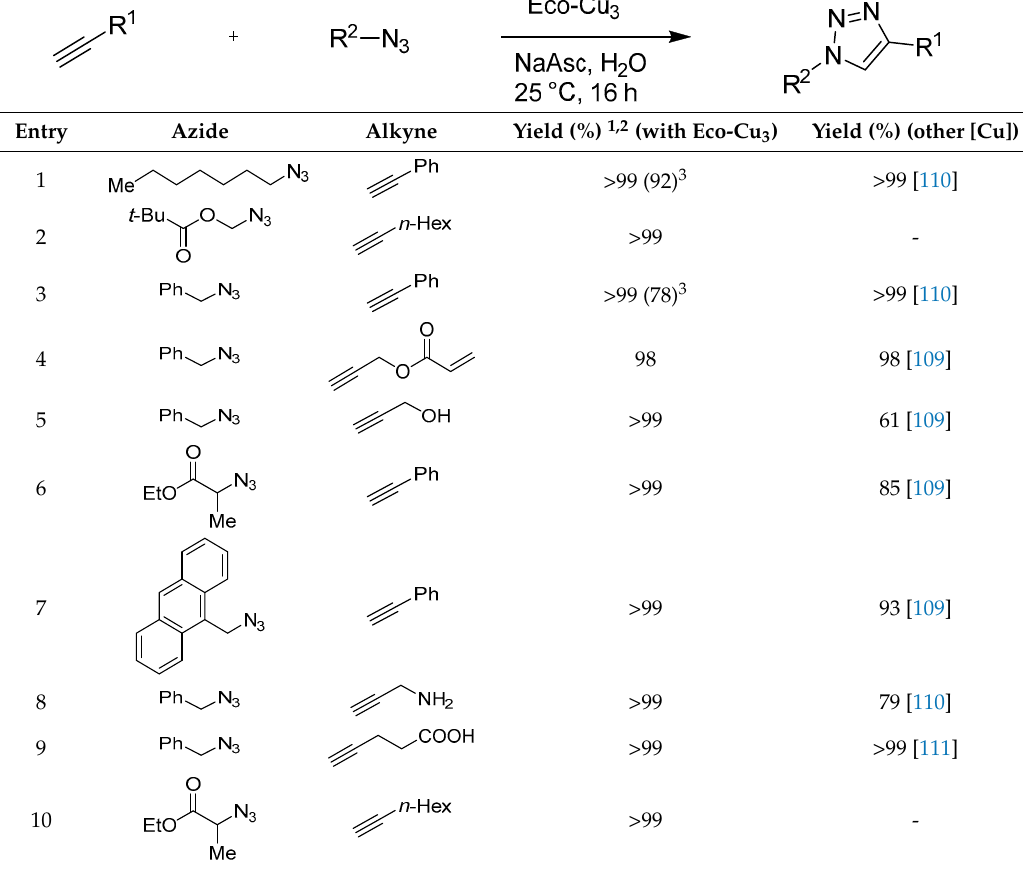
Table 11. A substrate scope of the Eco-Cu-catalysed CuAAC reaction.